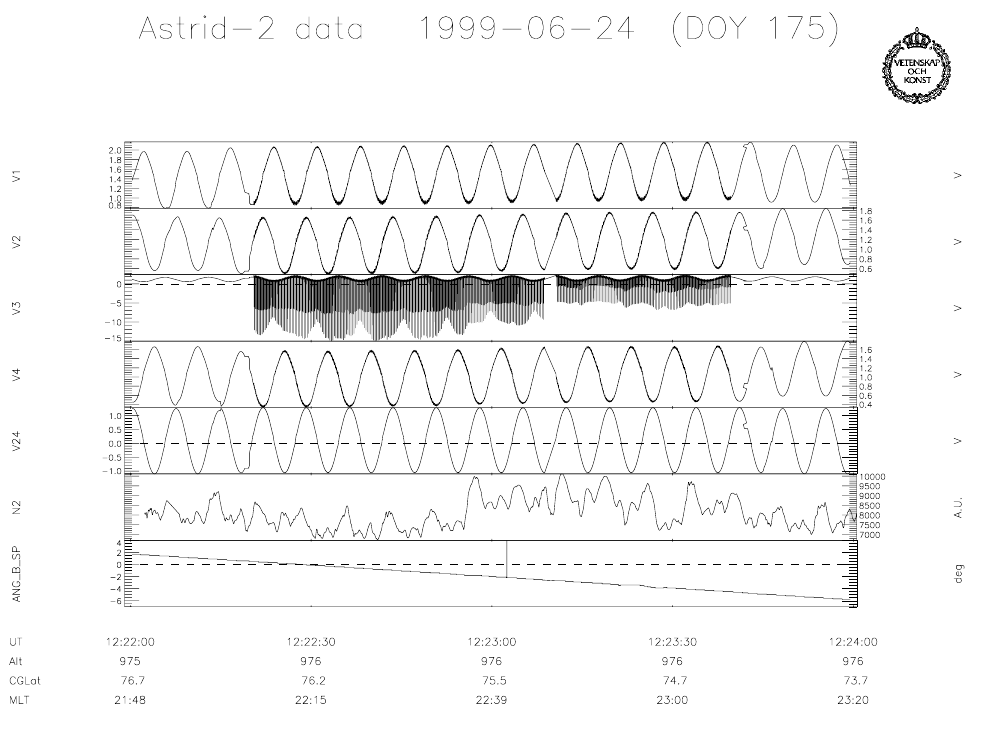
Fig. 14. EMMA measurements for Case 3. The format is the same as in Fig. 5.